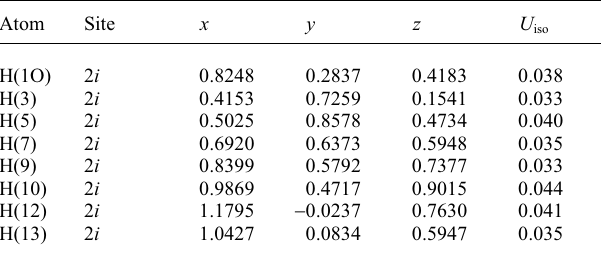
Table 2. Atomic coordinates and displacement parameters (in Å 2 )